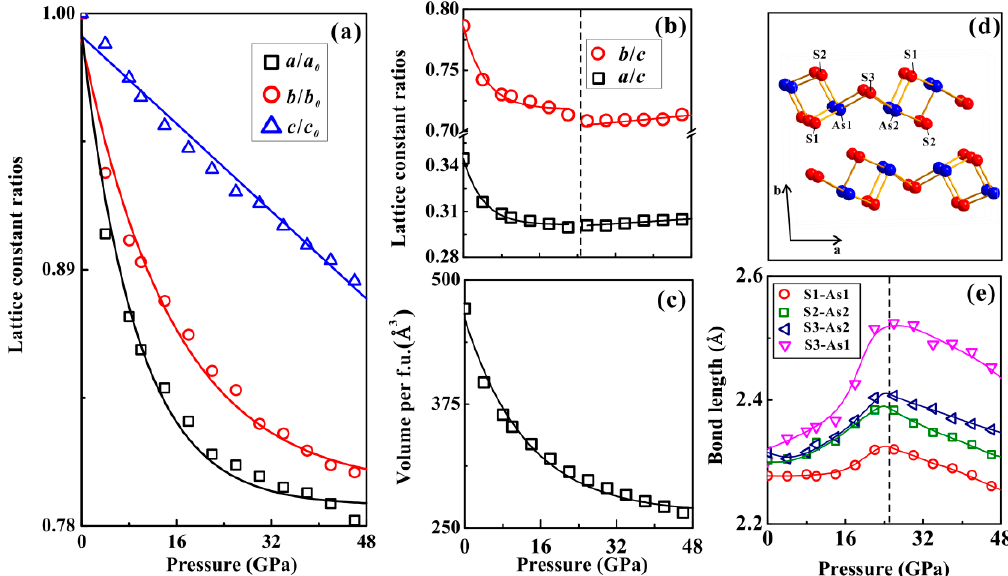
Figure 8. The variations of ( a ) lattice constant parameters ( a / a 0 , b / b 0 and c / c 0 ), ( b ) axial ratios ( a / c and b / c ), ( c ) unit cell volume and bond length for orpiment at high pressure. Two regions could be determined by the black vertical dotted lines at the pressure of ~25 GPa ( d ) Crystalline structure of monoclinic ( P 2 1 /c ) orpiment at ambient pressure. We also nominate the As and S ions in the crystalline structure. ( e ) Selected S-As bond lengths of orpiment up to 46 GPa.